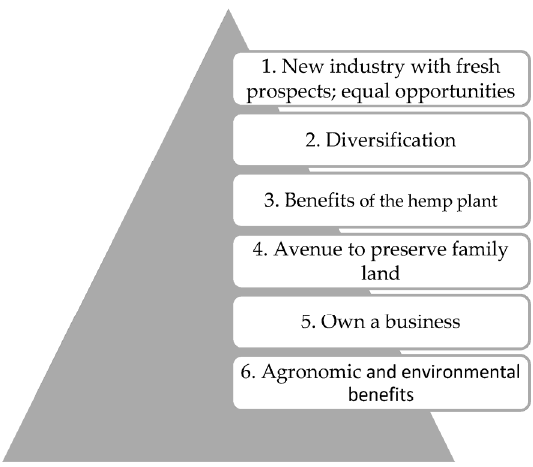
Figure 4. Factors in fl uencing NC farmers to grow hemp.